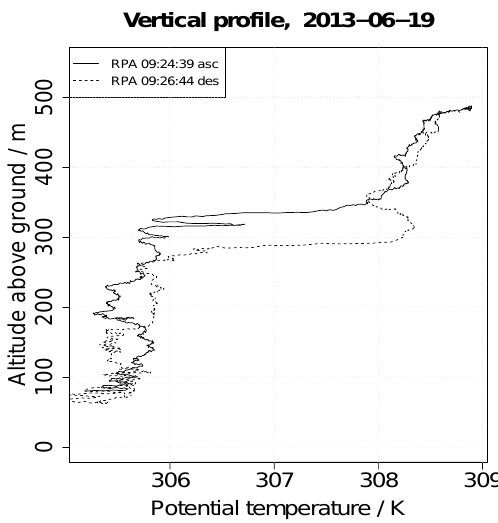
Fig. 15. Vertical profile of potential temperature measured just be- fore the racetrack pattern for the spectral analysis of the sensors.